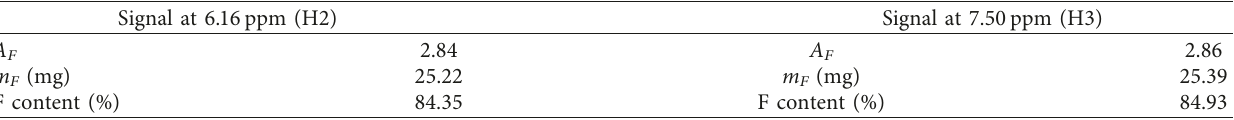
Table 4: Quantitation of 5-hydroxymethyl-2(5H)-furanone (F) in the dichloromethane leaf extract from H. lividus subsp. Corsicus by 1 H